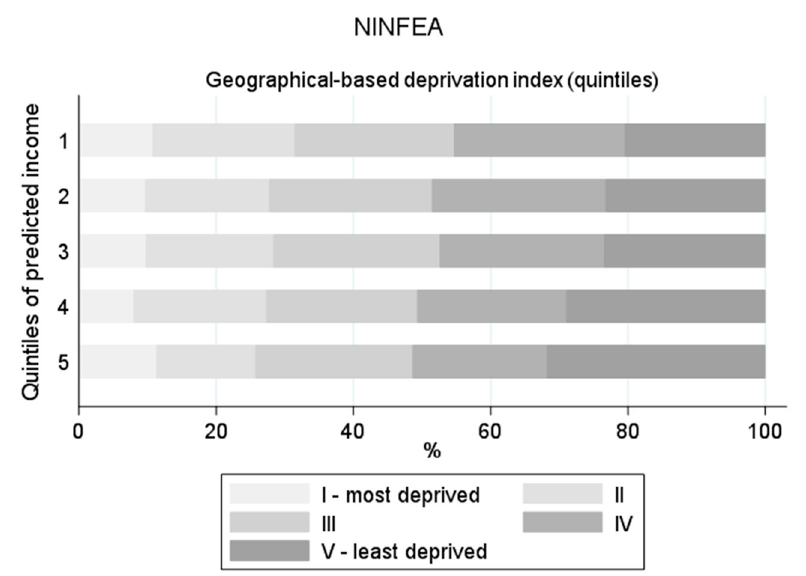
Figure 2. Distribution of the SEP-related variables available in the NINFEA cohort by quintiles of the predicted income.